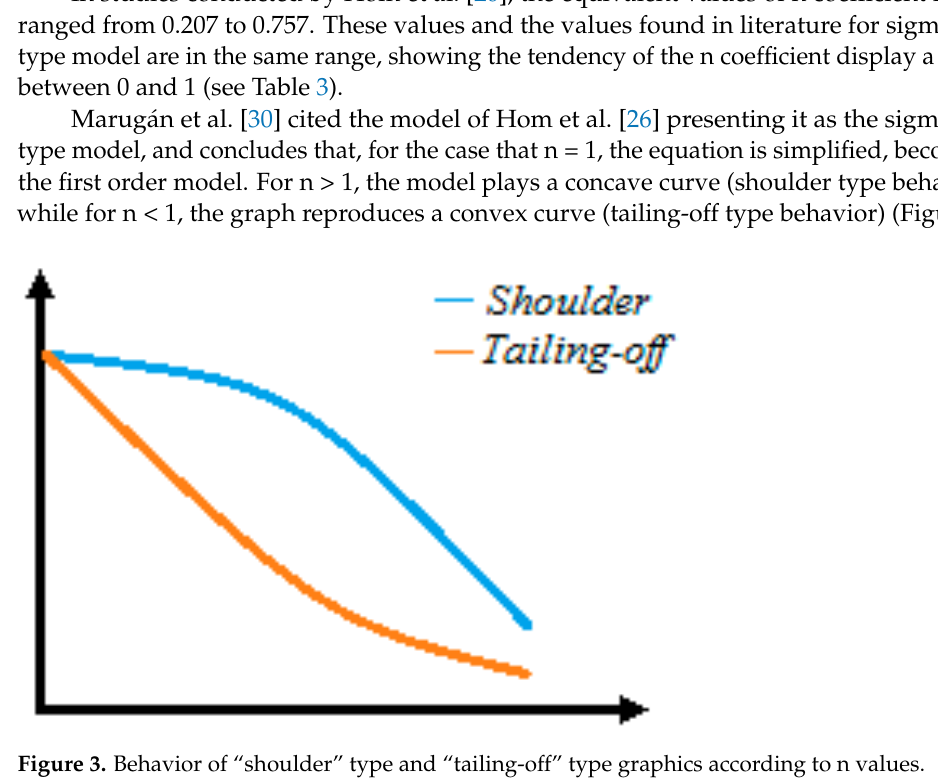
Figure 3. Behavior of “shoulder” type and “tailing-off” type graphics according to n